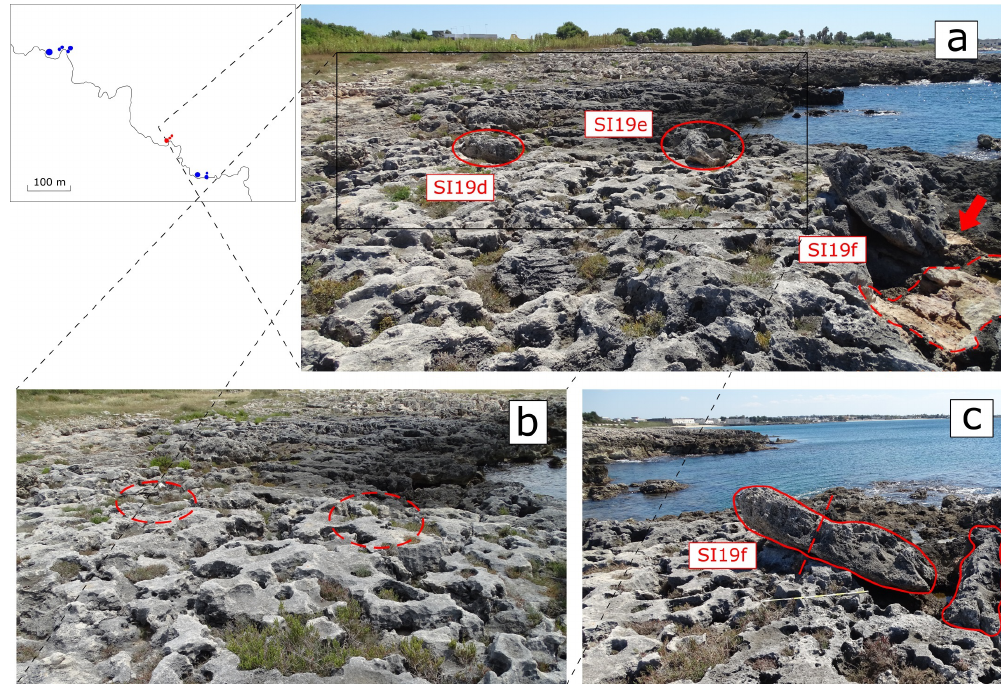
Figure A5. Comparison between pre- and post-storm states: ( a ) post-storm state of the zone of Boulders d, e, and f, the socket of Boulder f (red arrow), and the socket of Boulder e (dashed line); ( b ) pre-storm state (the post-storm locations of Boulders d and e are marked by dashed lines); ( c ) a pre-storm image of Boulder f with the fracture caused by the storm, the initial location (solid line) of Boulder